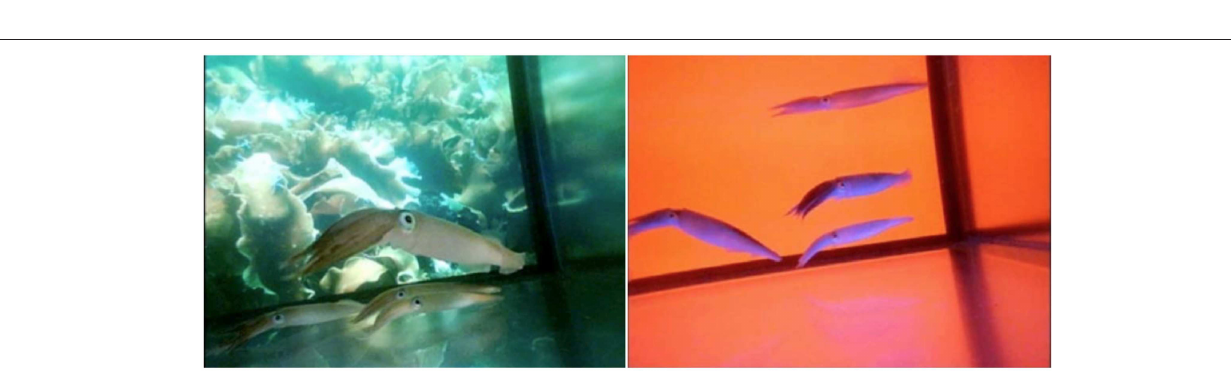
FIGURE 2 | Virtual reality used in a laboratory settings to study light stimulus response in Loligo opalescens . Image courtesy of Jules Jaffe, Scripps Institution of